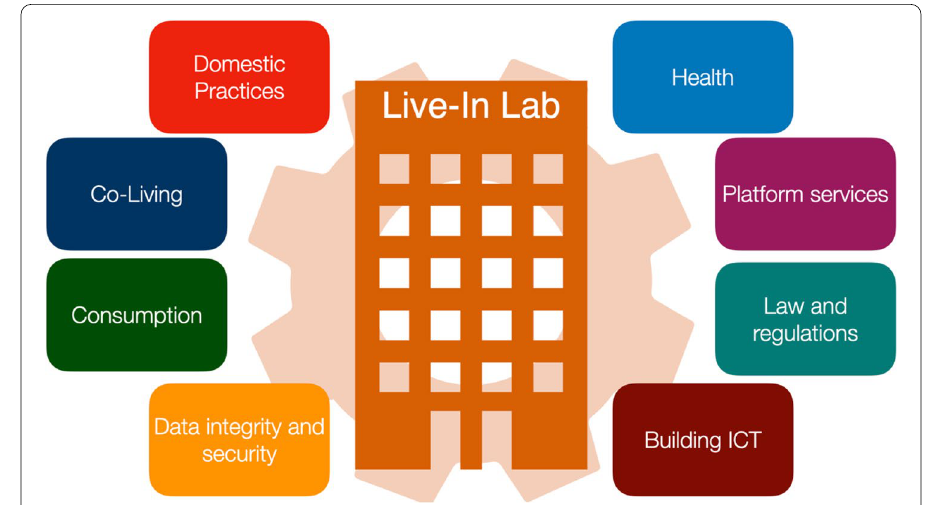
Fig. 1 Examples of research topics studied in the KTH Live-In